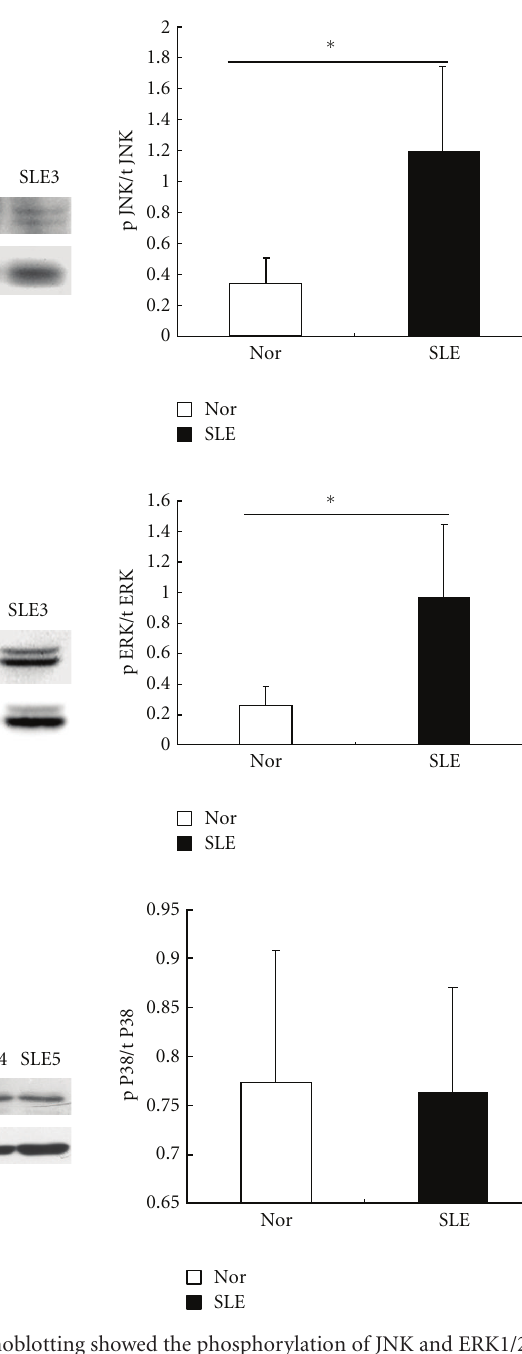
Figure 6: MAPK pathway in BMMSCs from SLE patients. Immunoblotting showed the phosphorylation of JNK and ERK1/2 was higher in BMMSCs from SLE patients. Results were shown as mean ± SEM. ∗ P < 0 . 05 (SLE versus normal controls by Student’s t -test). SLE: systemic lupus erythematosus, Nor: normal